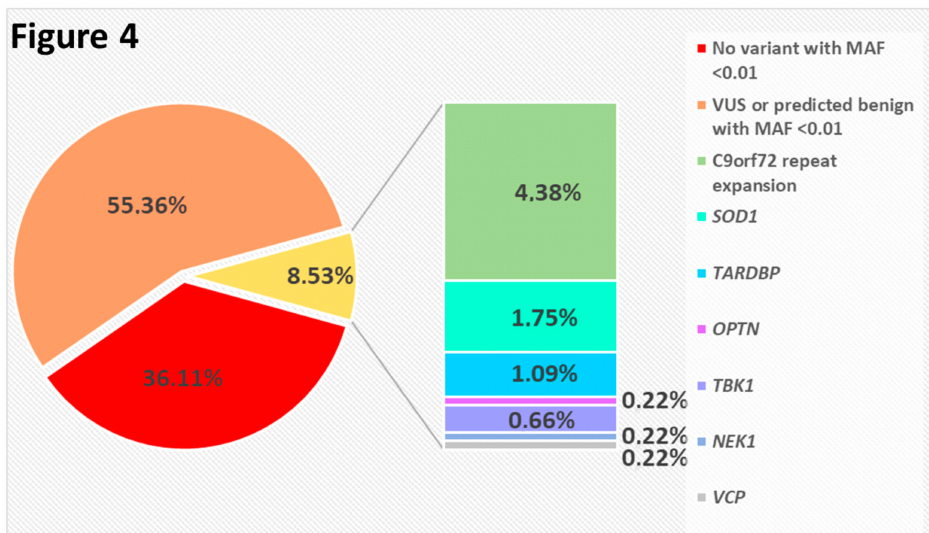
Figure 4. Pie chart showing the distribution of sporadic ALS cases in which we identified either a pathogenic variant in one of the indicated genes, or at least one sequence variant with MAF < 0.01 not classified as pathogenic or likely pathogenic, or no variant with MAF 0.01 at all. (VUS: Variant of uncertain significance).